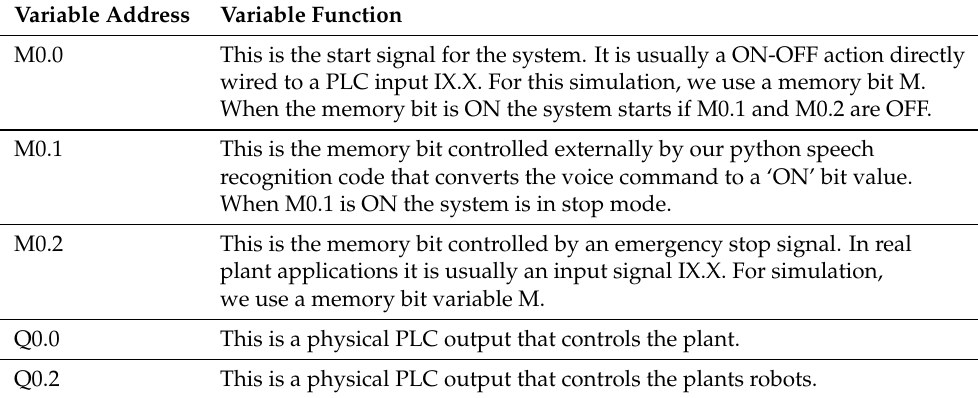
Table 1. PLC start and stop interlock